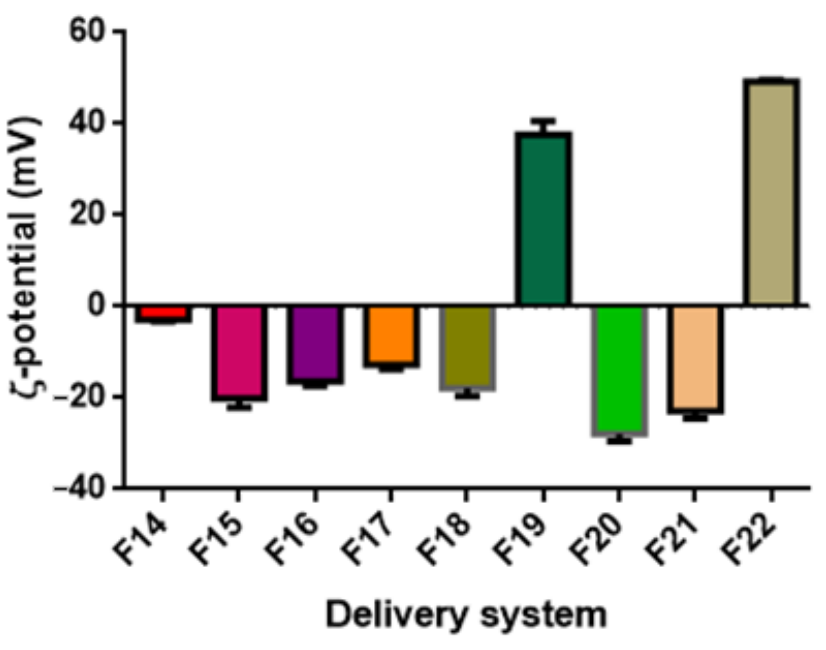
Figure 5. ζ -potential of TC1 EO nanoemulsions (formulations F1–F9) and nanoparticles (formula- tions F10–F13).